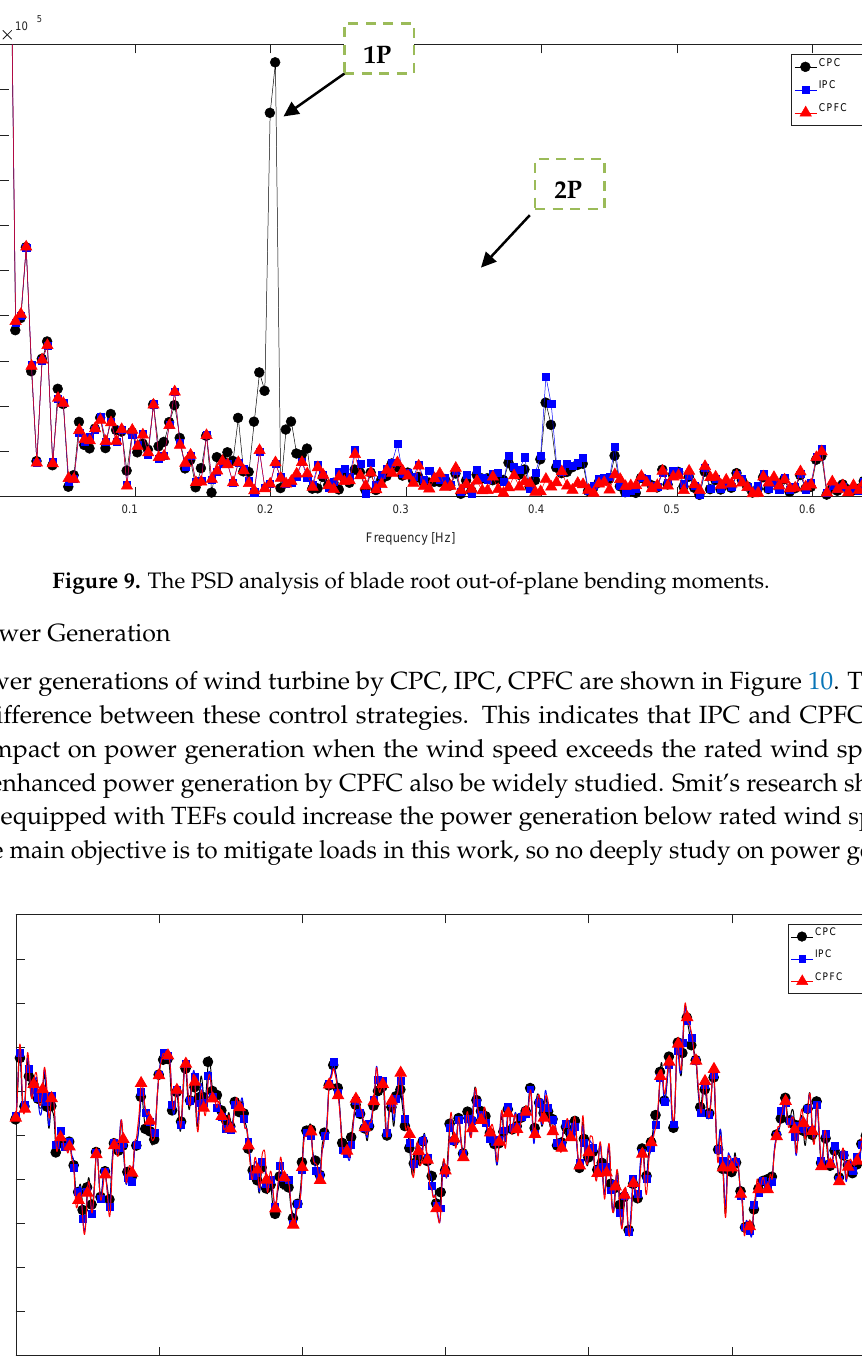
( b ) Figure 8. The blade tip deflections. ( a ) The blade tip out-of-plane deflections; ( b ) The blade tip in-plane deflections. Table 4. Standard deviation of blade tip deflections. CPC